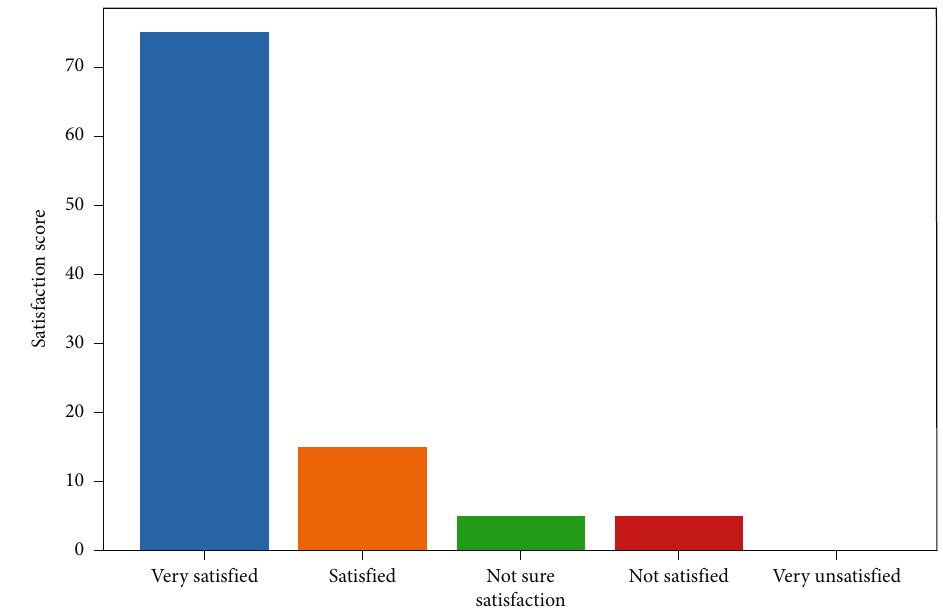
Figure 6: Overall experience evaluation of speech synthesis technology integrated into preschool children ’ s drama education.